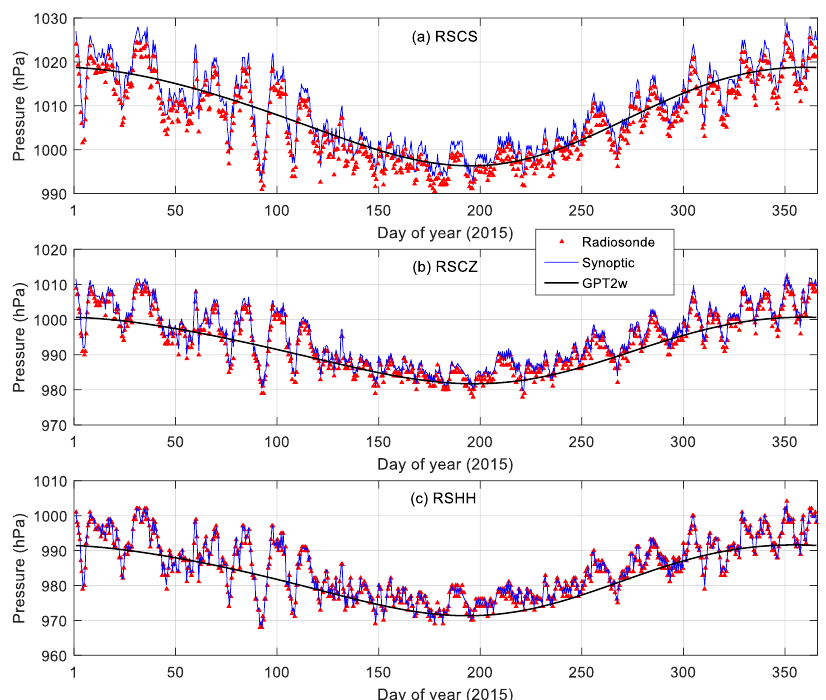
Figure 2. Time series of surface pressure provided by radiosonde, synoptic adjustment and GPT2w model over the whole year of 2015 at three radiosonde stations: (a) RSCS, (b) RSCZ and (c) RSHH, all of which are located in the Hunan Province,